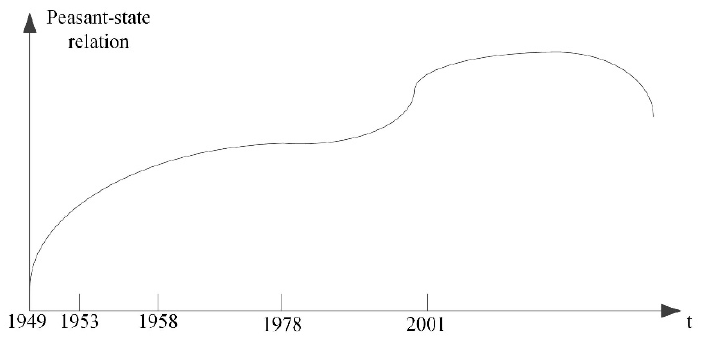
Figure 4. The changing relation of peasant and state.